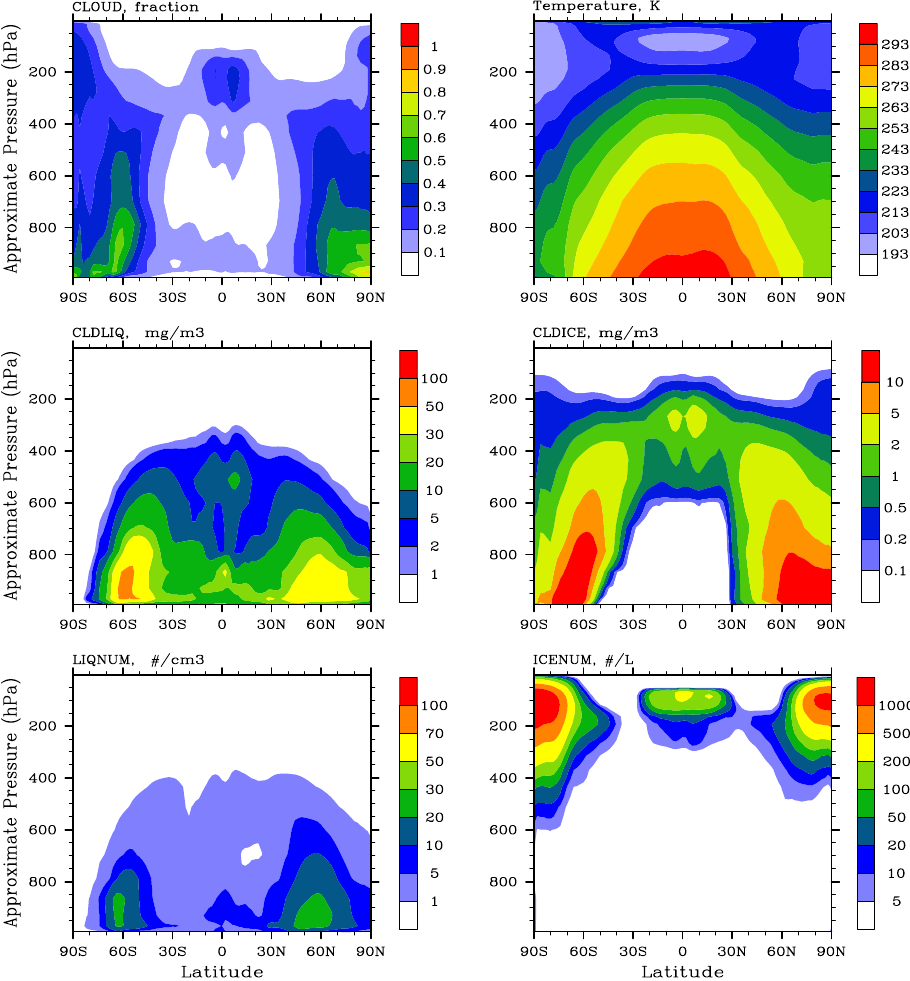
Figure 02 Fig. 2. Annual average zonal mean cloud fraction (CLOUD), temperature (K), grid-mean cloud liquid water content (CLDLIQ, mg/m 3 ), cloud ice water content (CLDICE, mg/m 3 ), cloud liquid droplet number (LIQNUM, #/cm 3 ), cloud ice crystal number (ICENUM, #/L) for the HOM